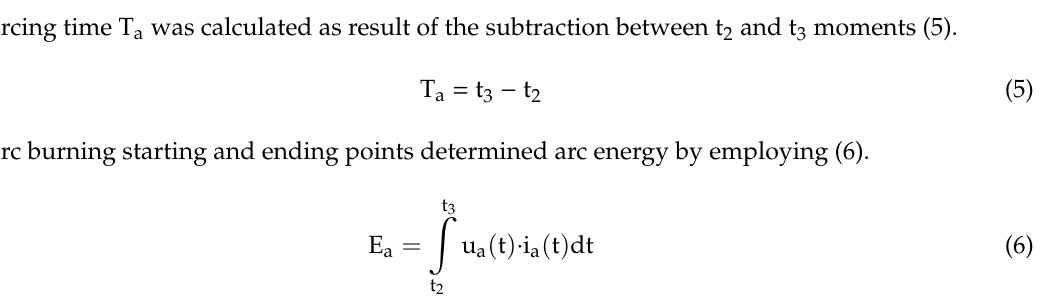
Figure 7. Average arc energy E a calculated for voltage waveforms for: ( a ) CI-1 ( b ) CI-2. As expected, as indicated in (6), arc energy calculated for various breaking moments varies according to arcing time: a smaller phase of the contact-breaking moment results in a higher arc energy, assuming the same conditions. This trend is observed for all presented groups of results and for both relays. Similar dependency was observed for CIs marked as CI-3 and CI-4. In the case of current waveforms induced by the A1–A5 voltage waveforms. the chopping current values were reached faster than for currents induced by the B1–B5 waveforms. Resulting arc energy for A-type waveforms reached lower values than did B-type waveforms. Because the rated currents of CI-1 (9 A) and CI-3 (6 A) are lower than the rated current of CI-2 and CI-4 (25 A), it is expected that CI-1 and CI-3 relays have lower arc-quenching capacity to that of CI-2 and CI-4. Figure 8 reveals the calculated arcing time T a for relays CI-1 and CI-2 for various voltage signals that have similar THD factor values, and for each of the current breaking moments. It is notable